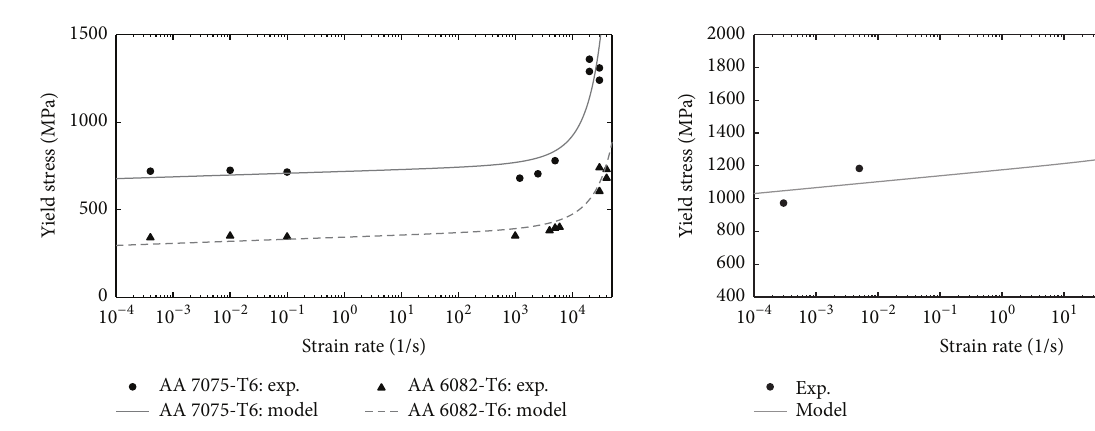
Figure 3: Comparison between experimental data (Mo´cko et al. [35]) and new modified Eyring equation for aluminum.